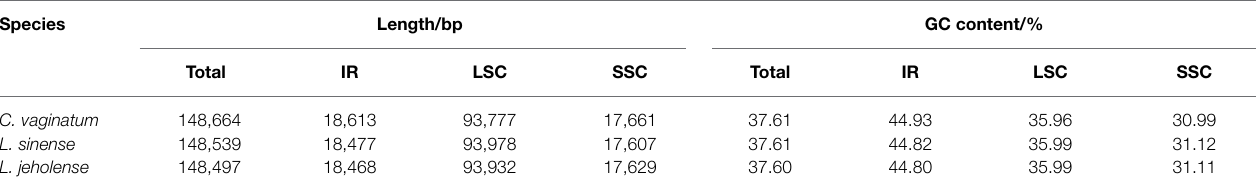
TABLE 1 | Base composition in the chloroplast genomes of Conioselinum vaginatum , Ligusticum sinense , and Ligusticum jeholense . Species Length/bp GC content/% Total IR LSC SSC Total IR LSC